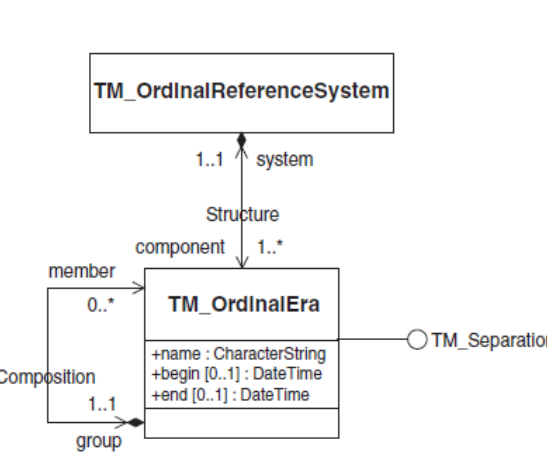
Figure 4 Ordinal temporal reference system (ISO,